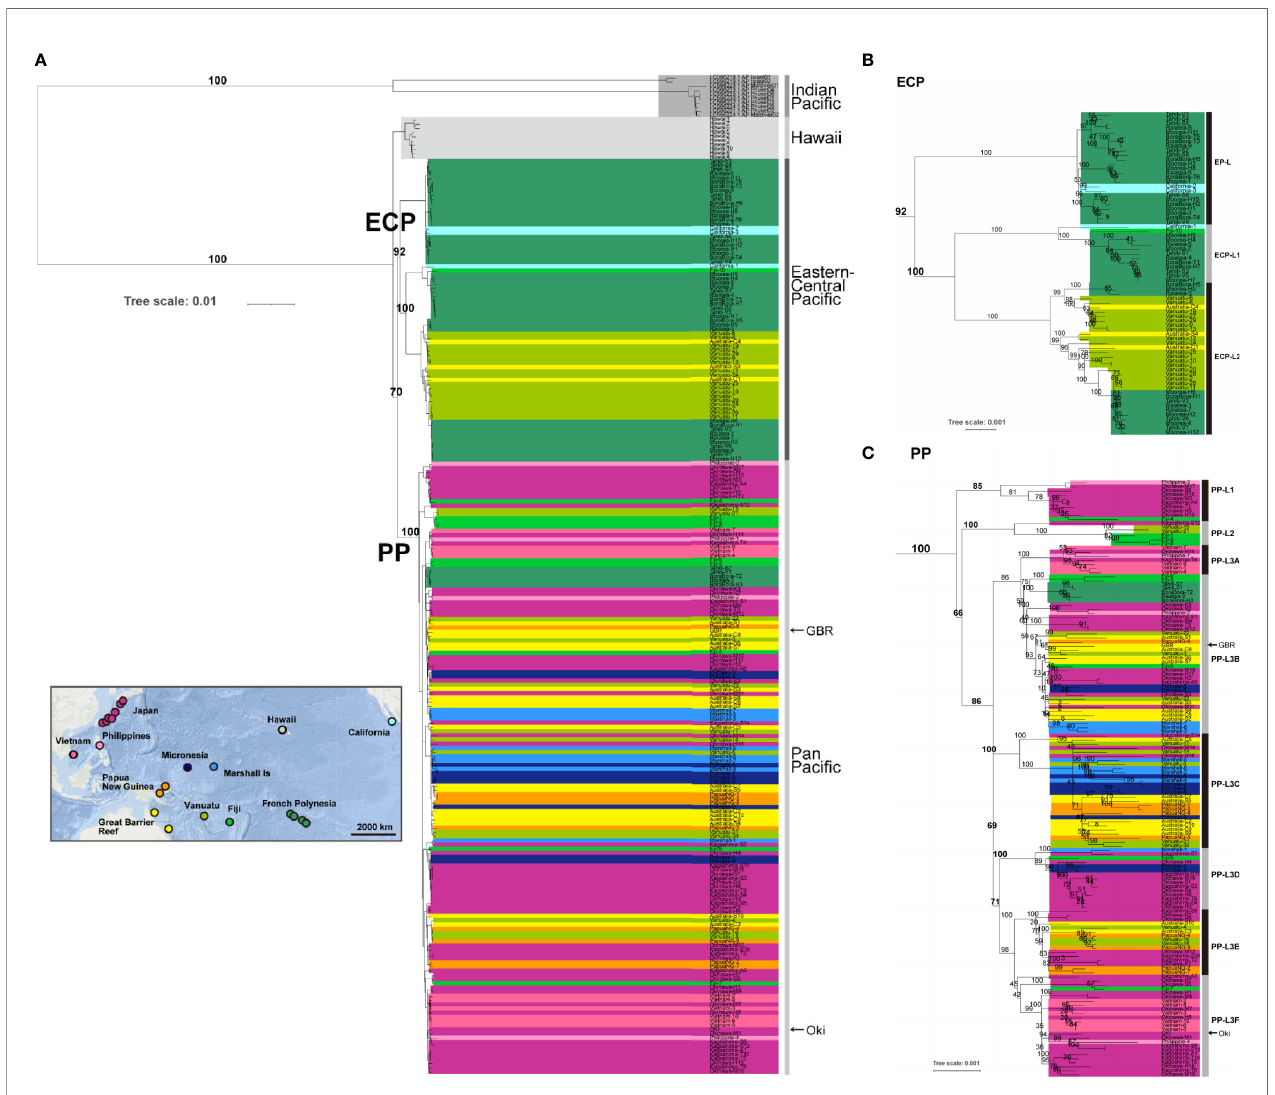
FIGURE 3 | A rooted phylogenetic tree of Acanthaster cf. solaris using the maximum-likelihood (ML) method, based on entire mitochondrial genome sequences (16,219 bp, including 1,822 variable sites). The A. planci of the Indian Ocean was used for rooting. Numbers at some nodes indicate bootstrap values based on 1000 replicates for internal branch support. Arrowheads at the right indicate sequences (OKI and GBR) decoded in the genome paper (Hall et al., 2017). (A) indicates the entire phylogeny, (B) is an enlargement of ECP clade, and (C) is for PP